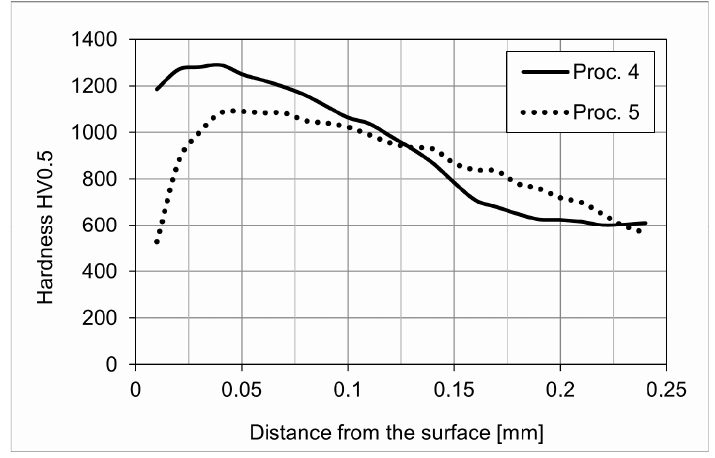
Figure 5. Results of hardness distribution in the nitrided layer analysis of X37CrMoV5 ‐ 1 steel after low ‐ pressure nitriding processes.